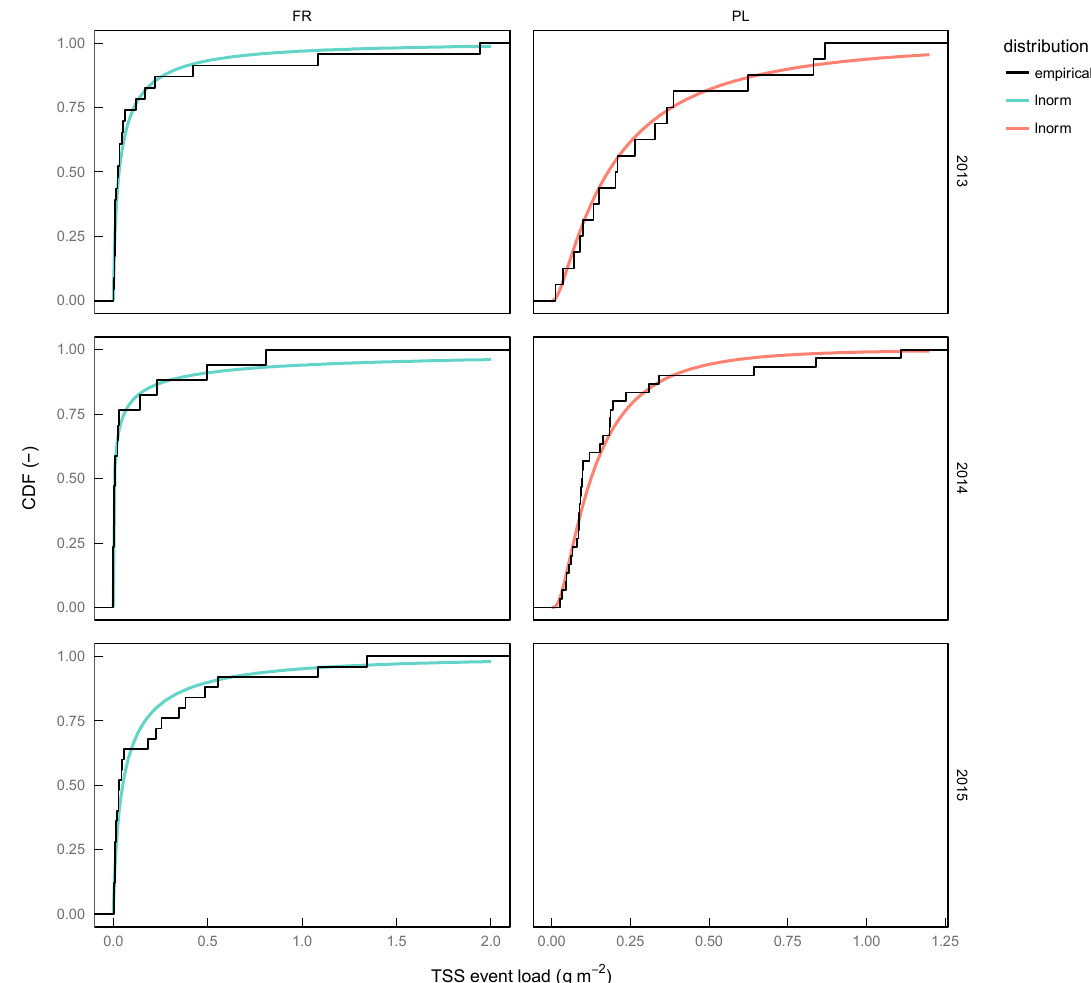
Figure 3. Approximation of empirical TSS event load distribution function grouped by year with lognormal distribution function at sites FR and PL.